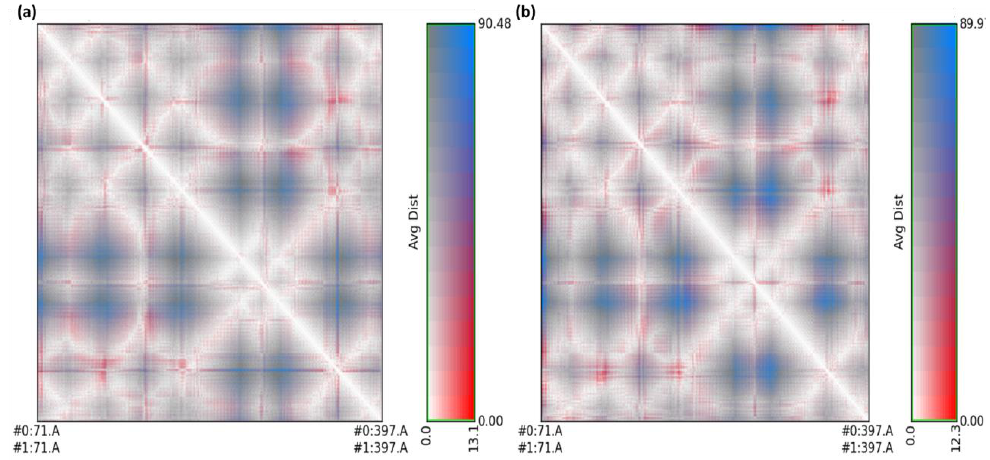
Figure 13. RR distance map displaying patterns of spatial interactions between ( a ) unbound serotonin receptor and serotonin receptor after simulation for RisS, and ( b ) unbound serotonin receptor and serotonin receptor after simulation for CTcS, showing average distance and standard deviation for all amino acid pairs.